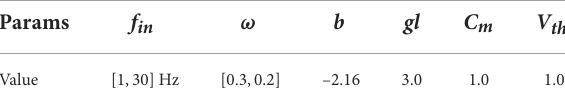
TABLE 2 Parameters setting of simulation